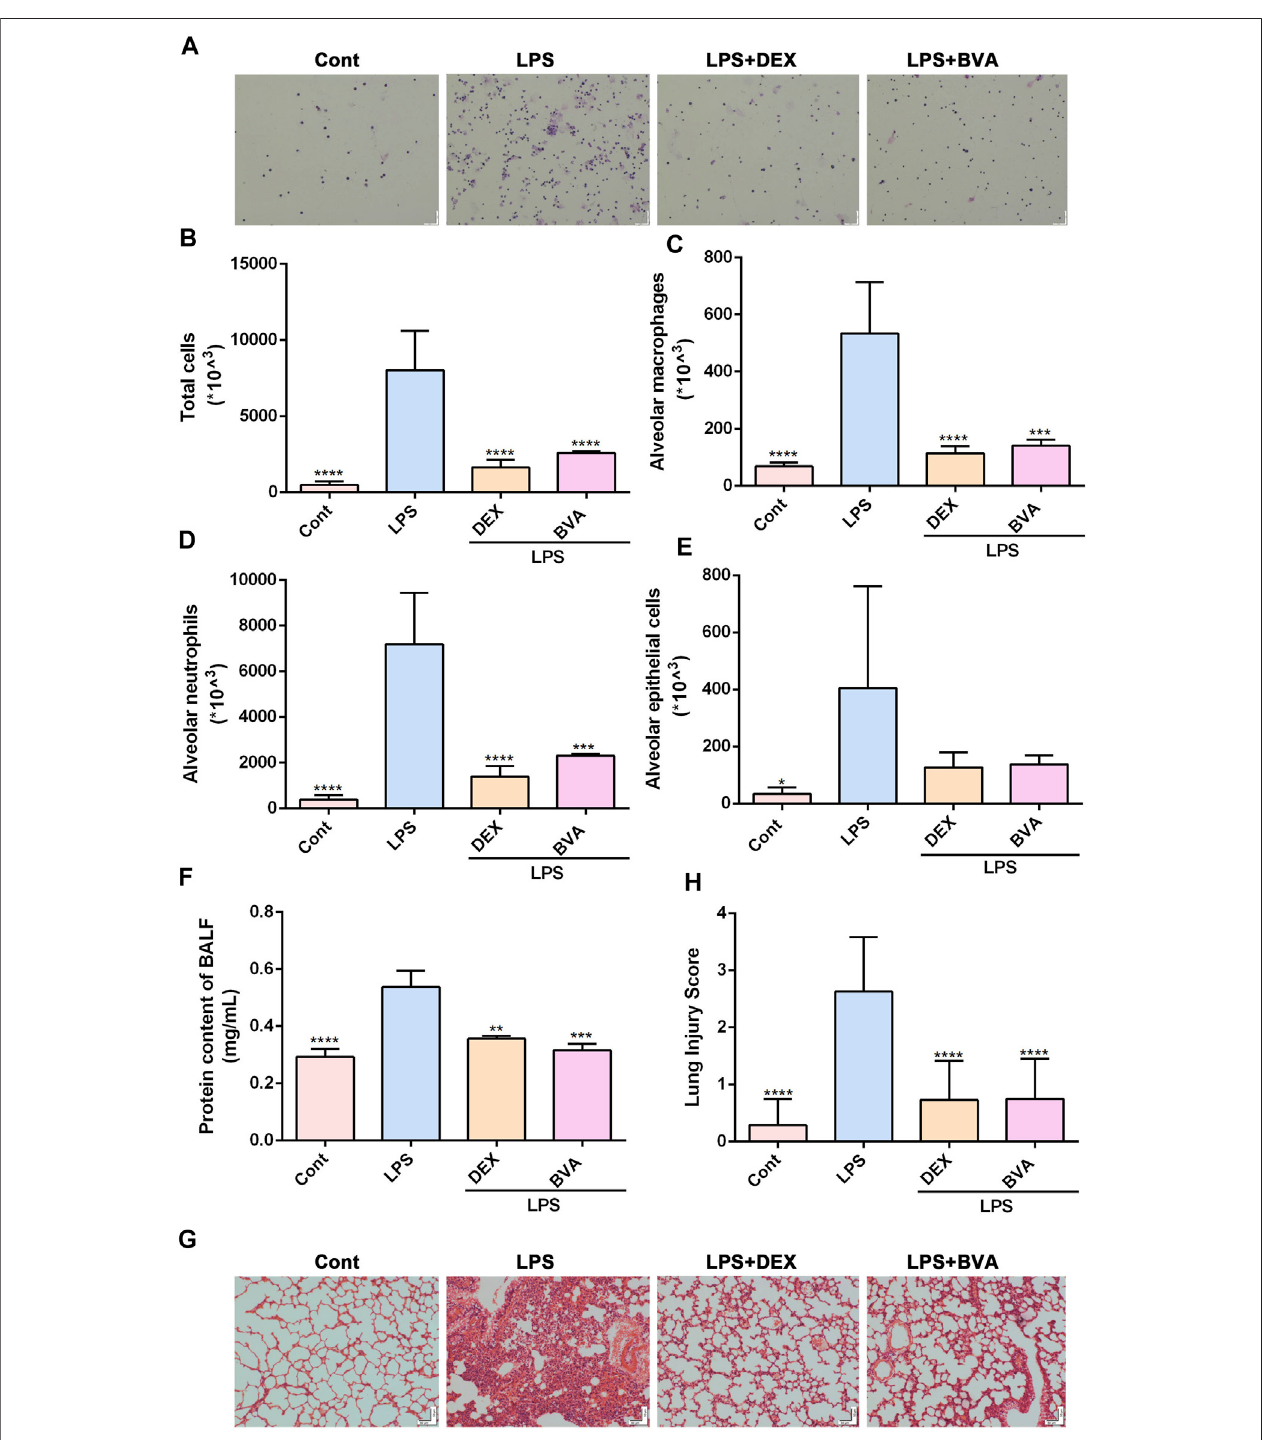
FIGURE 2 | Brevilin A attenuates LPS-induced ALI in vivo. After being exposed to LPS, mice were treated with BVA (20 mg/kg), DEX (5 mg/kg), or vehicle. (A) The representative Diff-Quick staining images of BALF cells were shown. The numbers of total cells (B) , alveolar macrophage (C) , neutrophils (D) , and epithelial cells (E) in BALFwerecounted. (F) TheproteincontentsinBALFweremeasuredusingBCAmethod.TheHEstainingwasusedtoassessthedegreeofin fl ammatorylunginjury. (G) The representative histopathological images of lung tissues are shown. Scale bar = 50 μ m. (H) The quantitative results of pathological scores are presented. DEX, dexamethasone. * p < 0.05, ** p < 0.01, *** p < 0.001, **** p < 0.0001, vs. LPS.